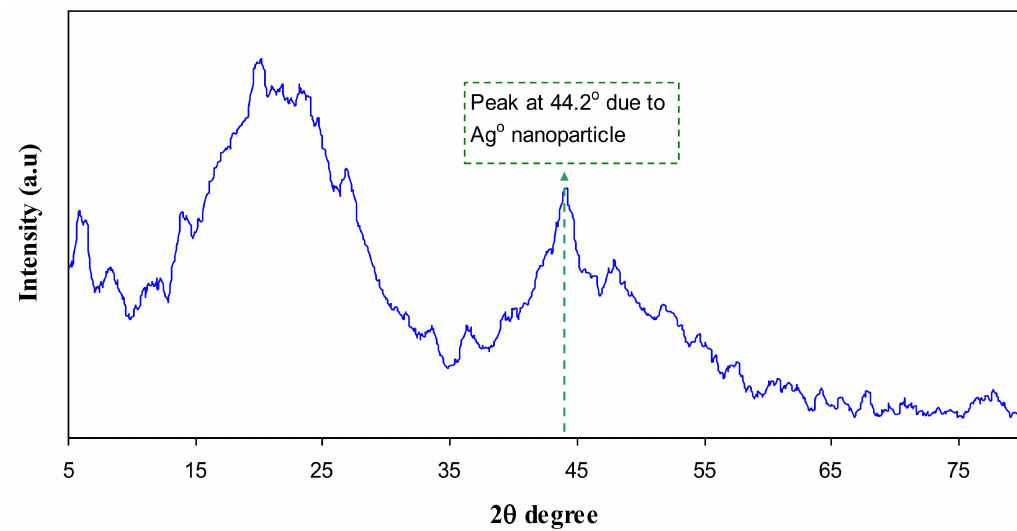
Figure 6. XRD pattern of PB4 polymer blend system.